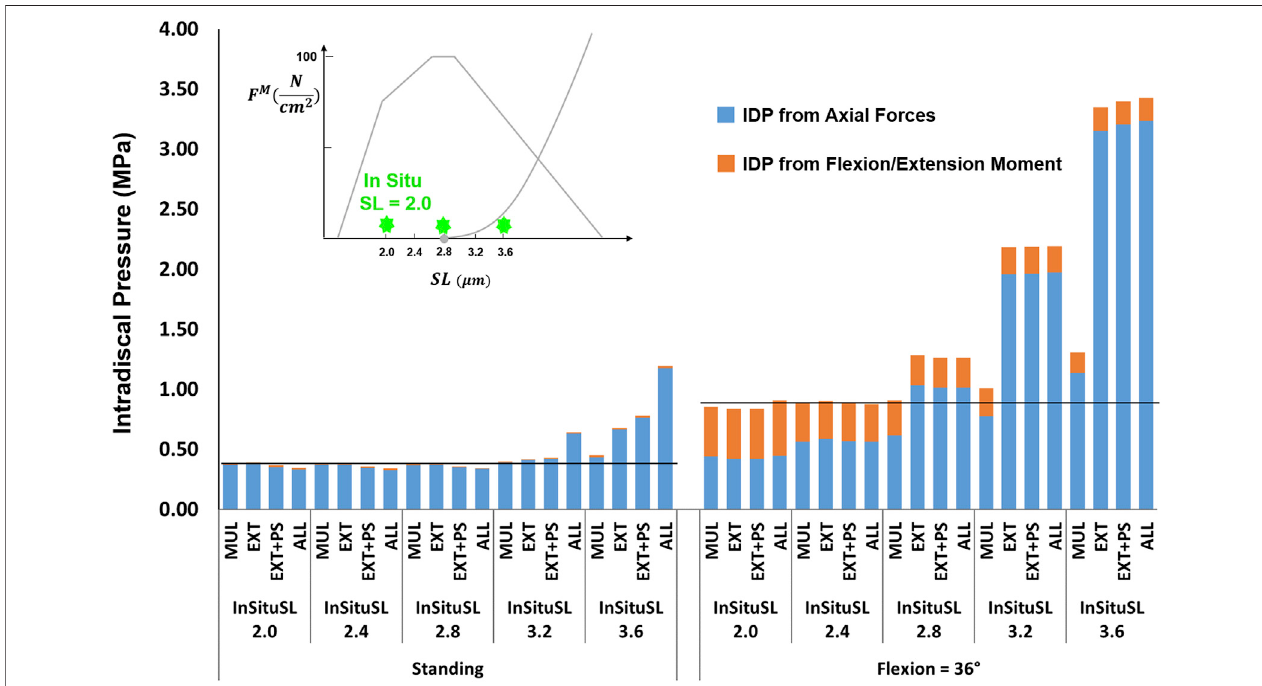
FIGURE 8 | The effect of different supine/prone in situ sarcomere length on L4-L5 IDP in upright standing and 36 ° fl exion for four scenarios: changes applied to multi fi dus (MUL), extensor muscles (EXT), extensor muscles, and psoas (EXT + PS), and all 210 muscles in the model (ALL). The black horizontal lines represent the baseline